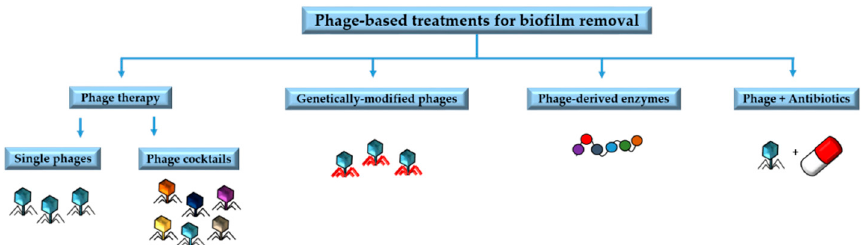
Figure 2. Main phage-based treatments for biofilm removal.